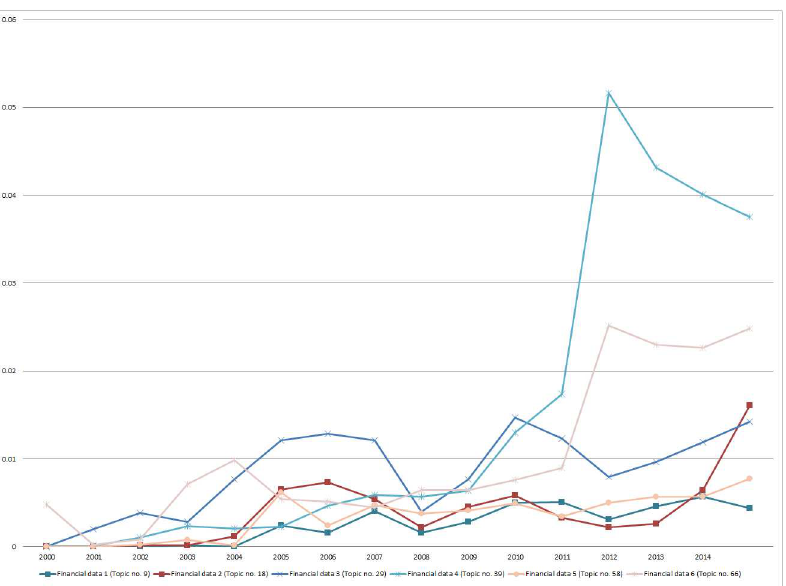
Fig 3. Trend analysis of mean probability of occurrence of financial data topics in the years2000 until 2014.